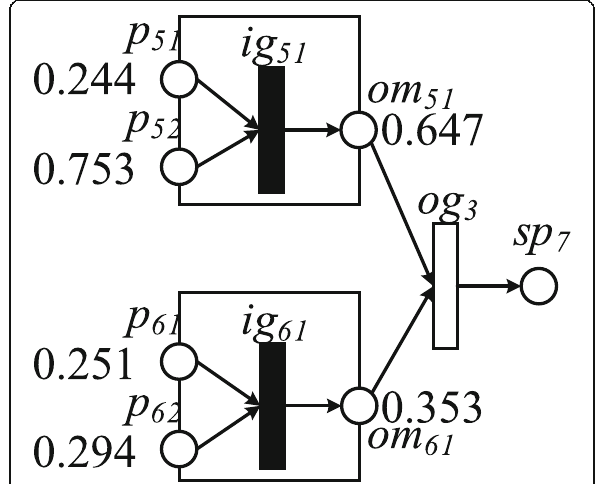
Fig. 11 COP model with attack probability